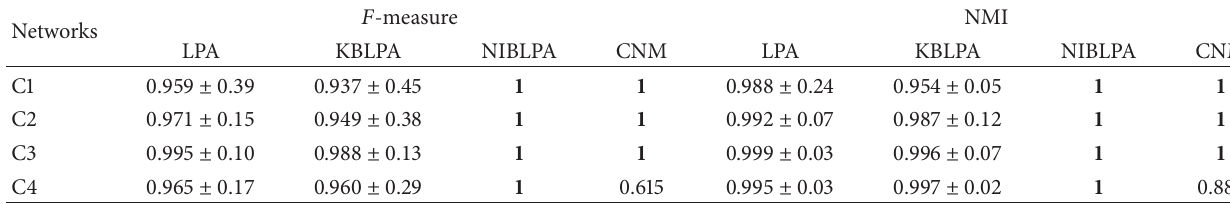
Table 5: The comparison of results on Clique-Ring